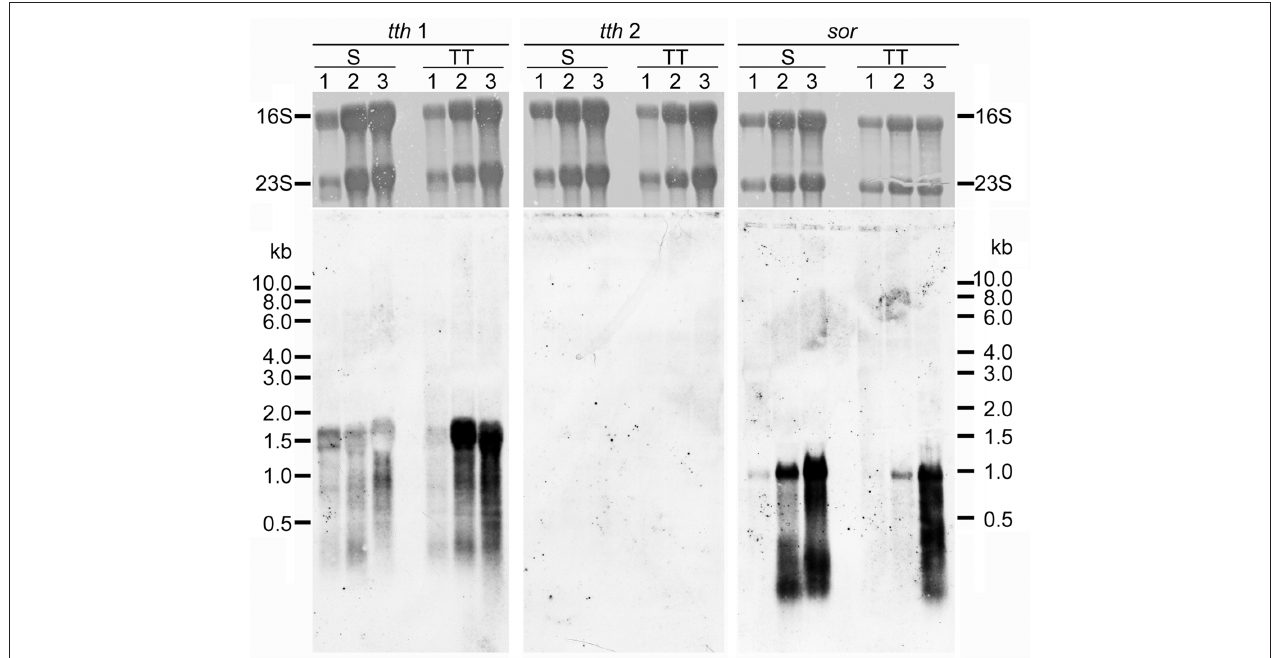
FiguRe 4 | northern hybridization of tth1 , tth2 , and sor genes. All lanes with total A. ambivalens RNA (5 μg each) isolated from cells grown with sulfur (S) or tetrathionate (TT) after 24 h (1); 48 h (2), and 72 h (3); upper panels, methylene blue staining for 16S and 23S rRNA; lower panels,